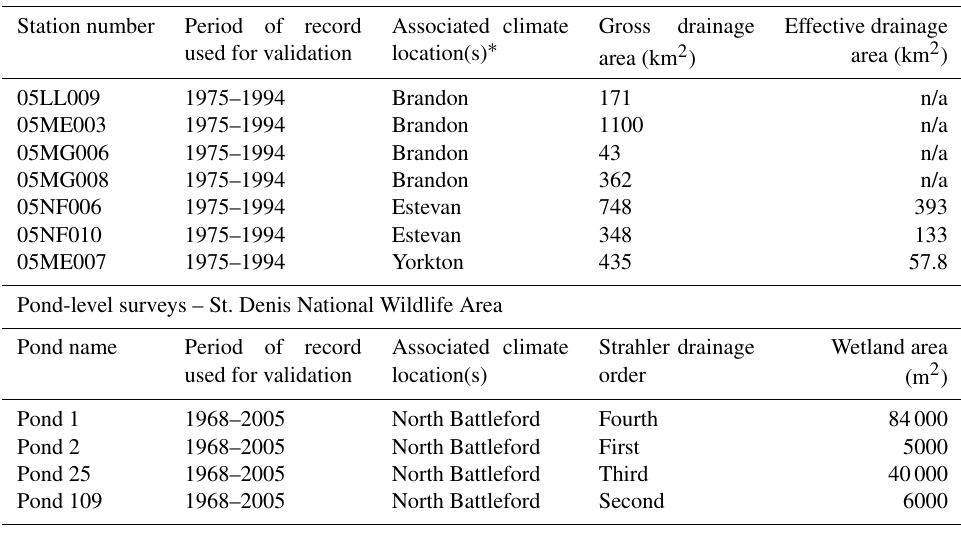
Table 3. Sources of observed data for model evaluation. Water Survey of Canada’s (WSC) hydrometric data were obtained from the HYDAT database, available at https://collaboration.cmc.ec.gc.ca/cmc/hydrometrics/www/ (last access: 2 November 2022). Effective drainage area is defined by Godwin and Martin (1975) to be the drainage area that contributes water to the gauged location during the median annual flood and was also obtained from HYDAT. These are unavailable for many Manitoba basins and are likely underestimates for Saskatchewan basins because of wetland drainage subsequent to the calculation. Pond-level data were obtained from the University of Saskatchewan. Note: n/a is not